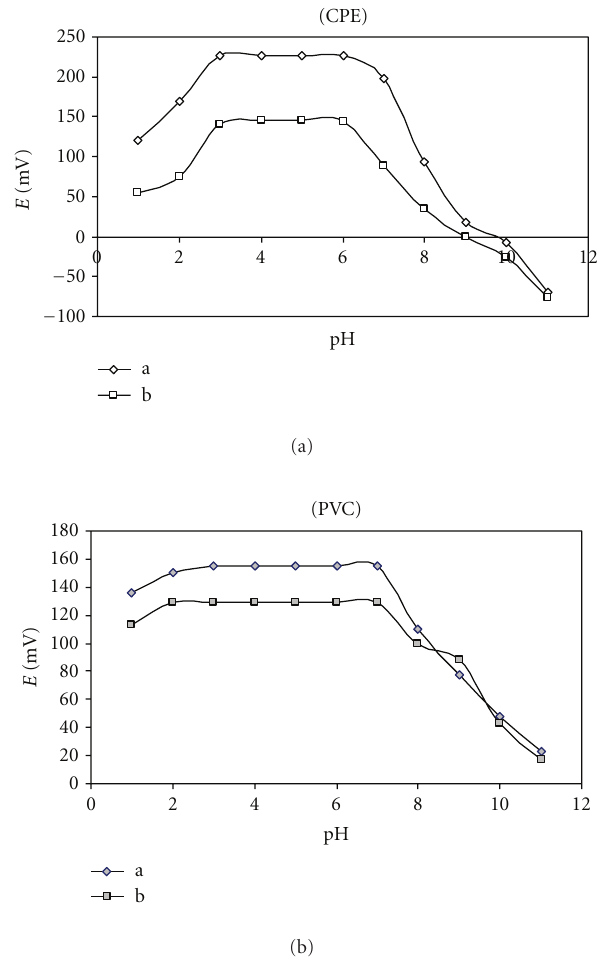
Figure 3: E ff ect of pH on (a) 10 − 2 and (b) 10 − 4 molL − 1 of KTF on the potential readings of CPE and PVC membrane electrodes.